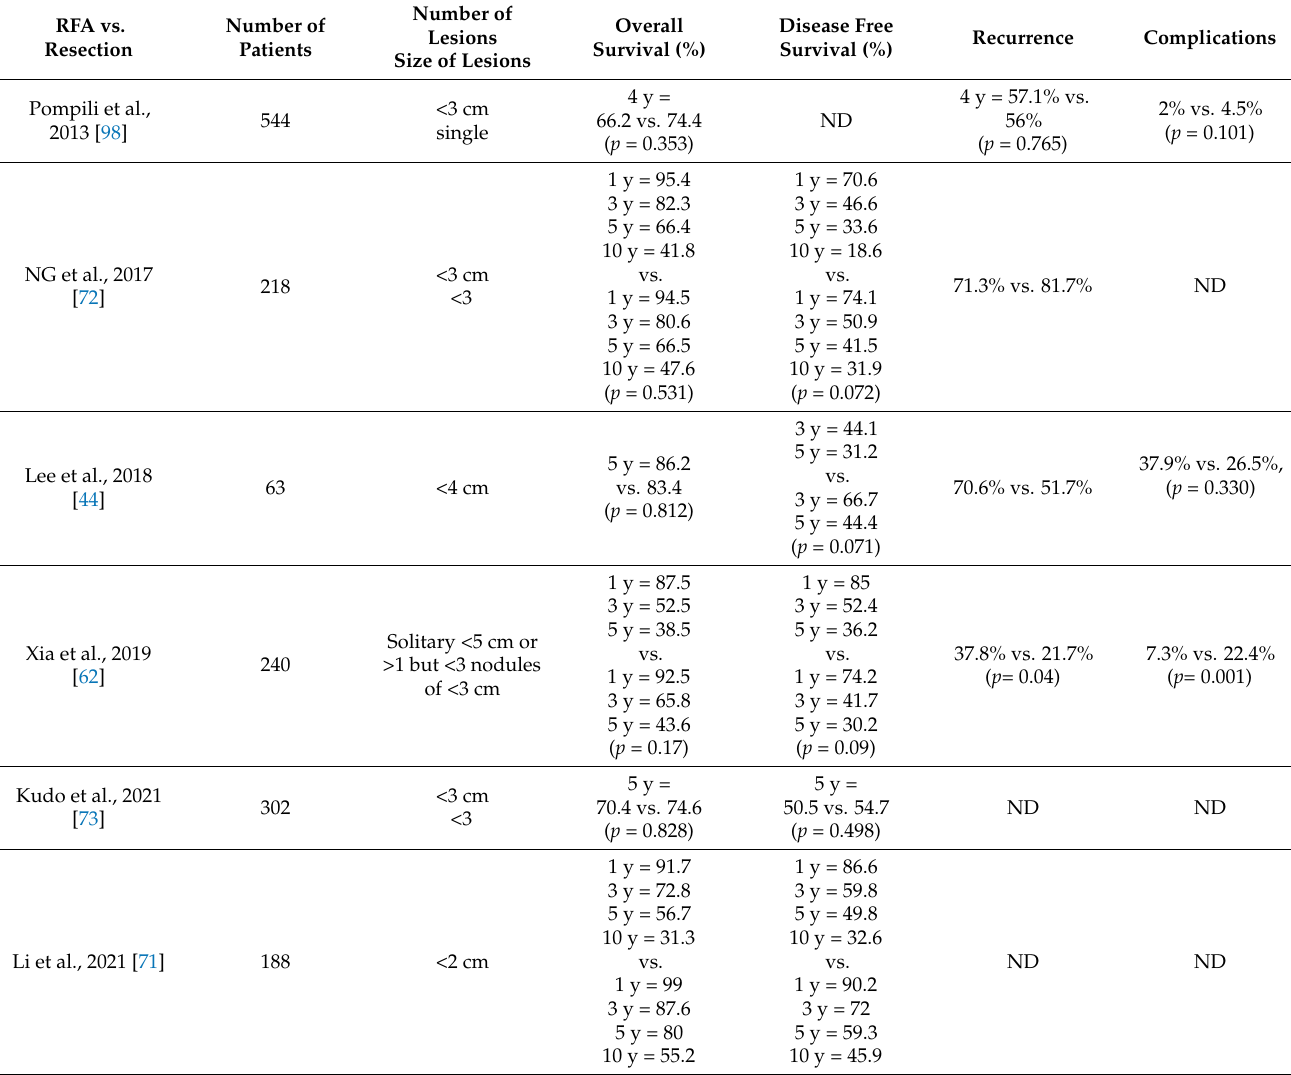
Table 1. Summary of recent studies comparing Radiofrequency ablation (RFA) and Resection. RFA vs.